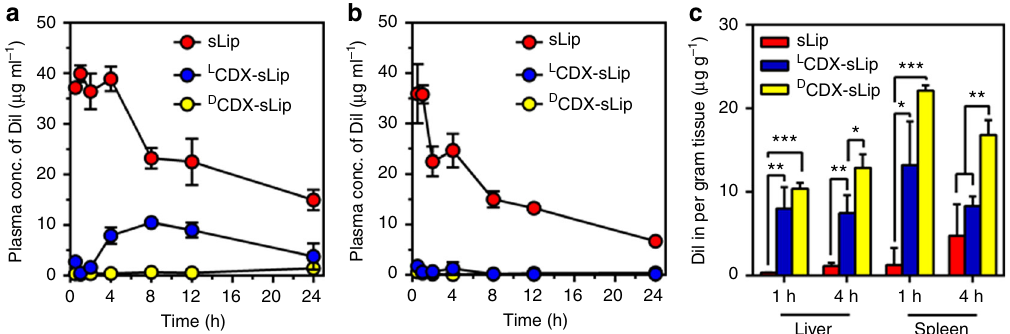
Fig. 3 Pharmacokinetic pro fi le and biodistribution of DiI-loaded sLip, L CDX-sLip, and D CDX-sLip. a Plasma concentration of DiI determined at 30 min, 1 h, 2 h, 4 h, 8 h, 12 h, and 24 h after intravenous injection in BALB/c mice. b The ABC effect of different liposomal formulations. BALB/c mice were injected with a low dose of empty liposomes (sLip, L CDX-sLip, and D CDX-sLip, 5 mg HSPC per kg of mouse), followed with a second injection of the normal dose of DiI- loaded liposomes 5 days after the fi rst injection (50 mg HSPC per kg of mouse). c Biodistribution of liposomes in liver and spleen of BALB/c mice. n = 3, data are means ± s.d. Statistical signi fi cances were calculated by Student ’ s t -test. * p < 0.05, ** p < 0.01, *** p <